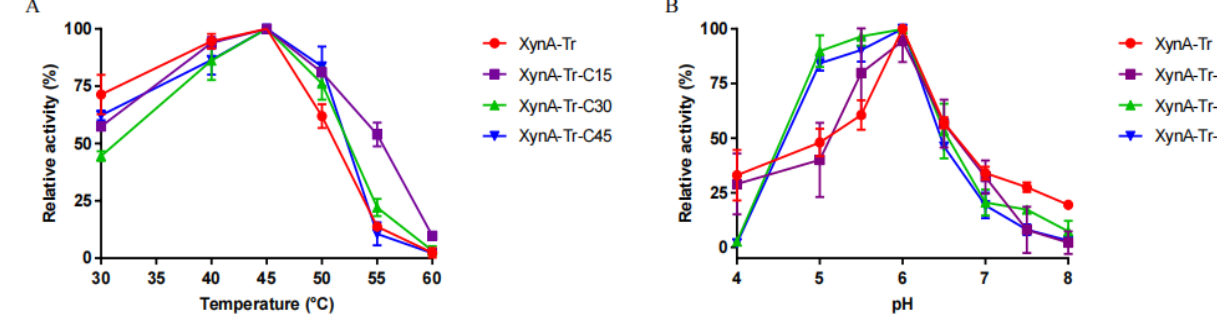
Figure 7. Effects of temperature ( A ) and pH ( B ) on the activity of the variants.